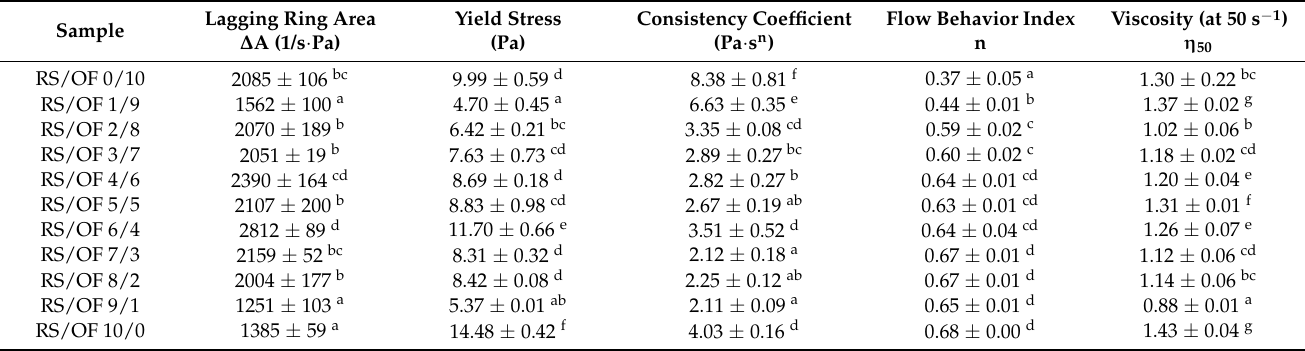
Table 3. Rheological parameters of rice starch and oat mixture system. RS: rice starch; OF: oat